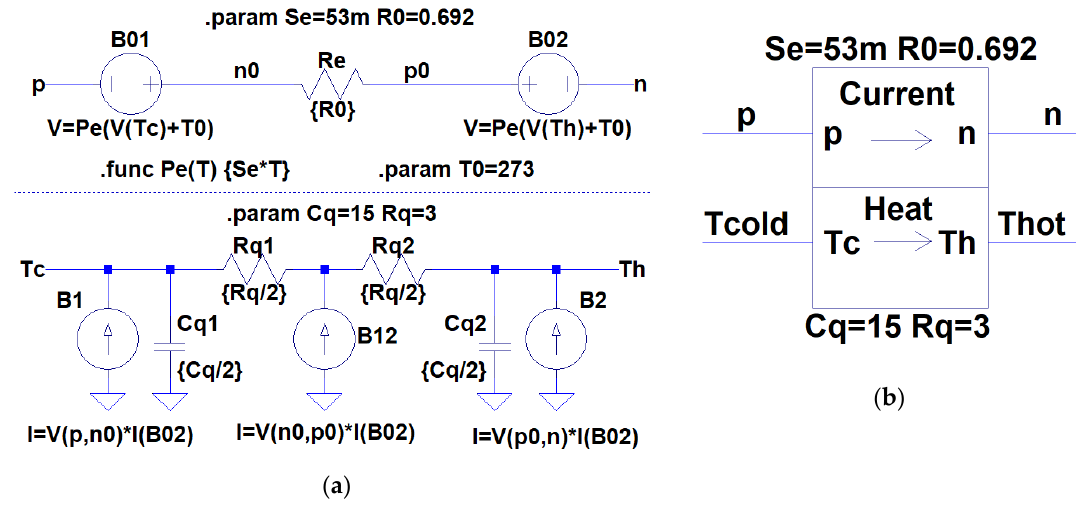
Figure 2. ( a ) Kubov’s LTspice TEG model; ( b ) Subcircuit of TEC1-12722 along with calculated